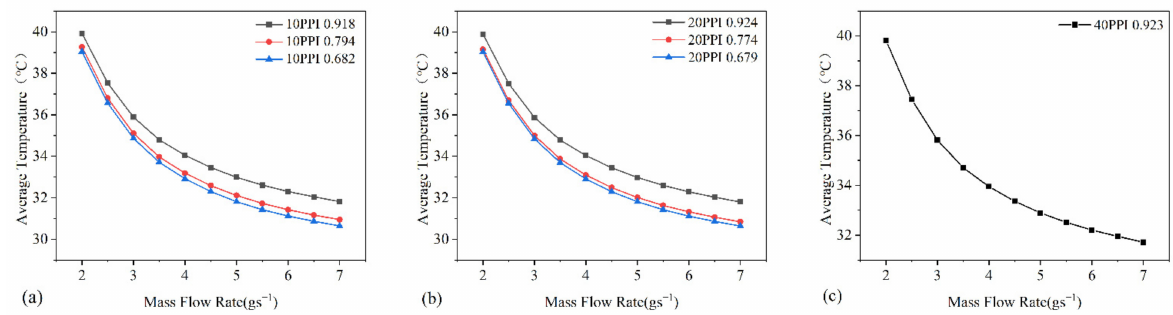
Figure 6. The average temperature of the battery with different parameters of AFHS: ( a ) 10 PPI aluminium foam; ( b ) 20 PPI aluminium foam; ( c ) 40 PPI aluminium foam.